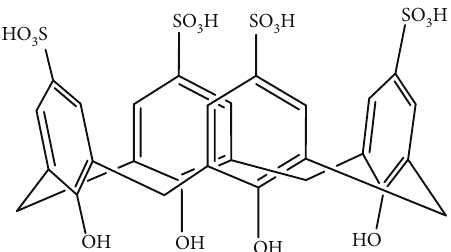
Figure 1: Chemical structure of calix[4]arene bearing sulphonate groups on the